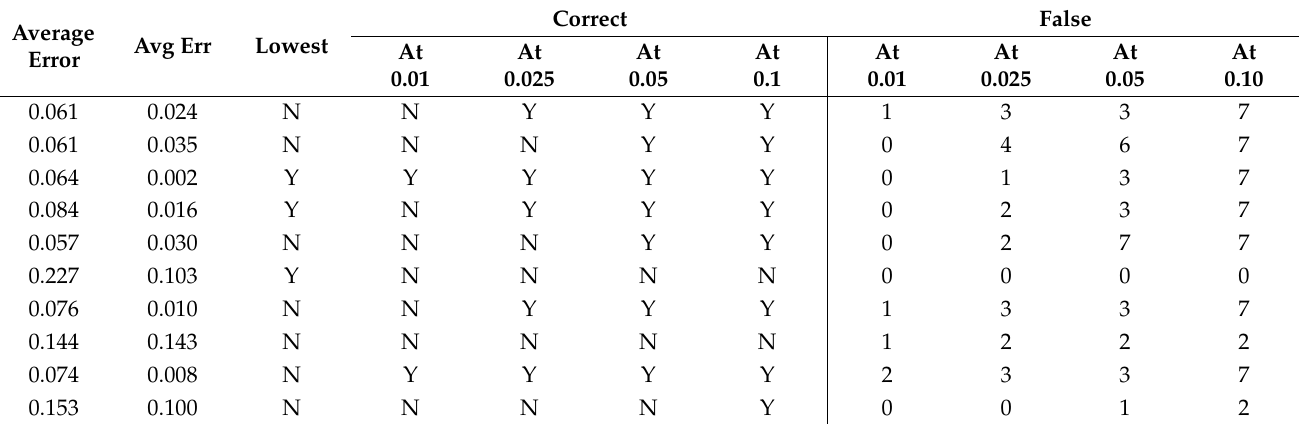
Table A59. Set 1, trials 31–40 summary data (single 0.5 PR value).